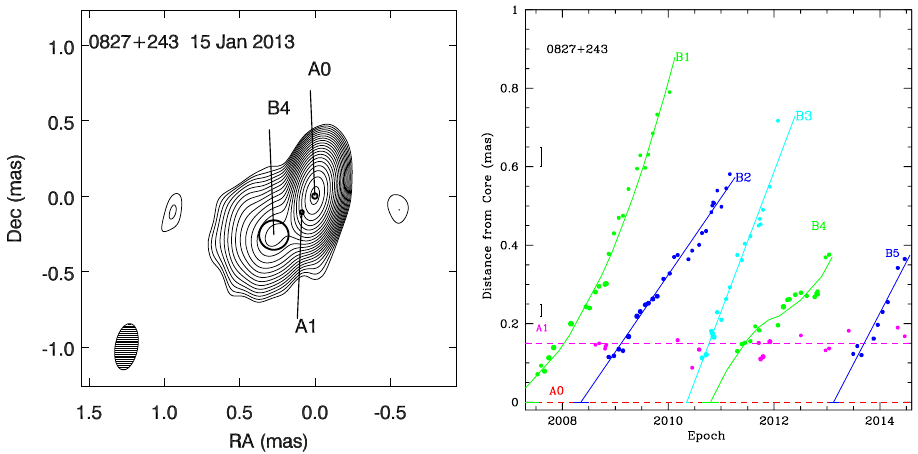
Figure 2. Left: Total intensity map of 0827+243 at 43 GHz with I peak = 1093 mJy/beam, with a Gaussian restoring beam of 0.15 × 0.31 mas 2 at PA = − 10 ◦ (in the bottom left corner); contours represent 0.125%, 0.176%, 0.25%, ... 64%, 90.51% of the peak intensity; black circles indicate position and size of components according to model fits; Right: Distance of moving knots B 1 (green), B 2 (blue), B 3 (cyan), B 4 (green), and stationary feature A 1 (magenta) with respect to the core; solid curves correspond to motion of knots, dashed horizontal lines show position of the core and stationary feature. The vertical segments on the left show 1 σ position uncertainties at different distances from the core: as shown in [20] the positional errors of a knot are inversely proportional to the brightness temperature of the knot and, therefore, increase with distance from the